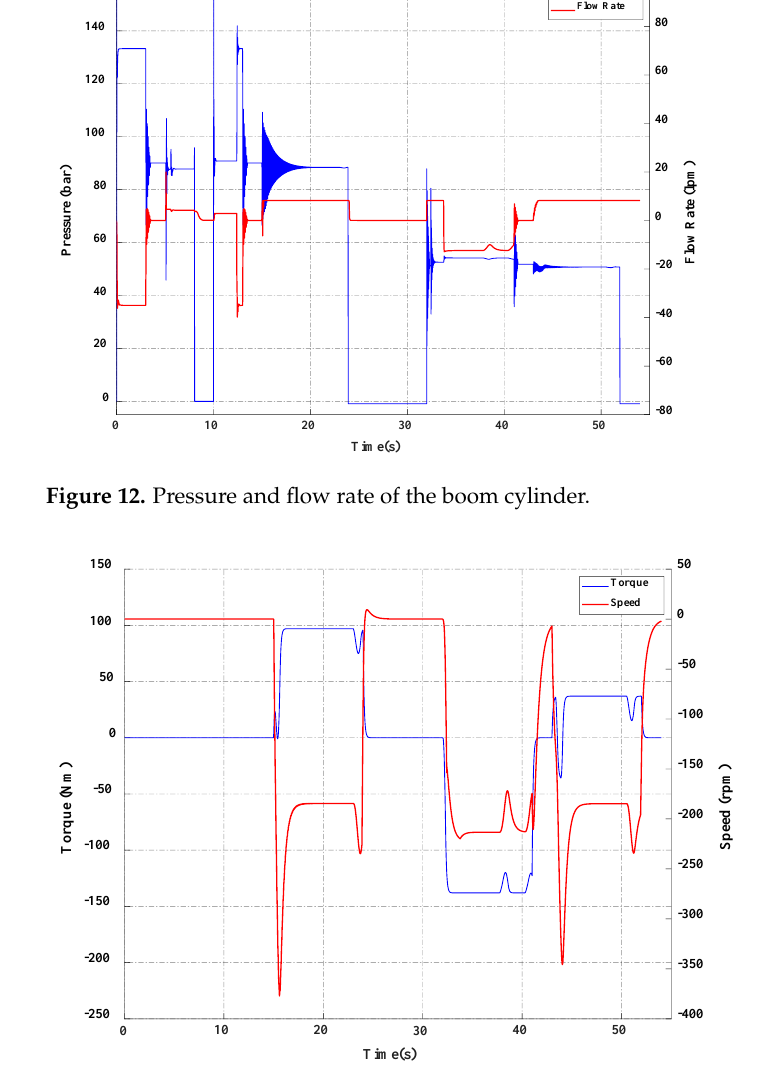
Figure 13. Torque and speed at the shaft of electrical motor/generator.